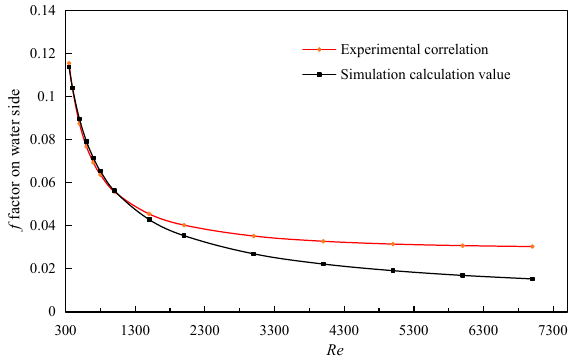
Figure 7. Comparison of f factors on water side.